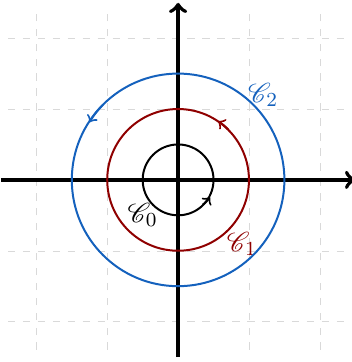
Figure 1 . Example of “ordered” contours with r =